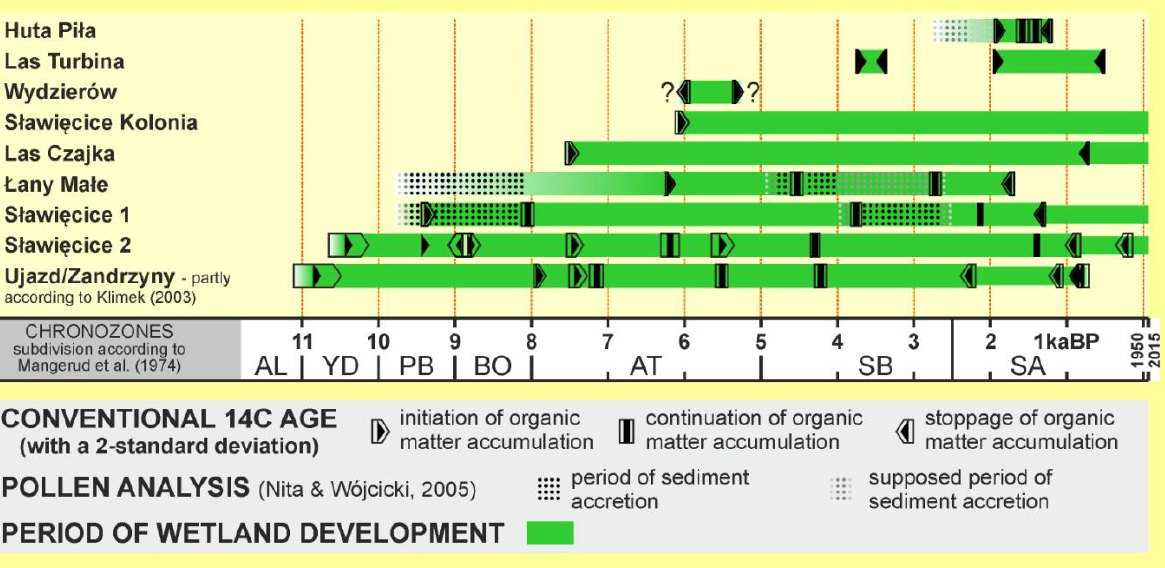
Fig. 6. Reconstructed periods of wetland development in the lower reach of the Kłodnica